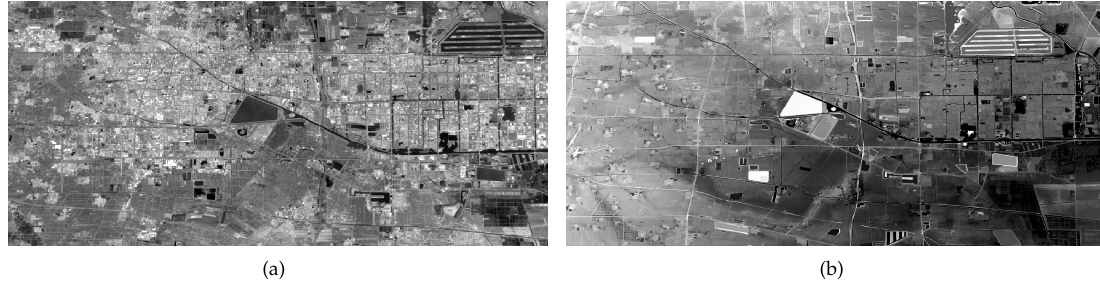
Figure 5. The reference evaluation data: ( a ) DOM and ( b ) digital elevation models